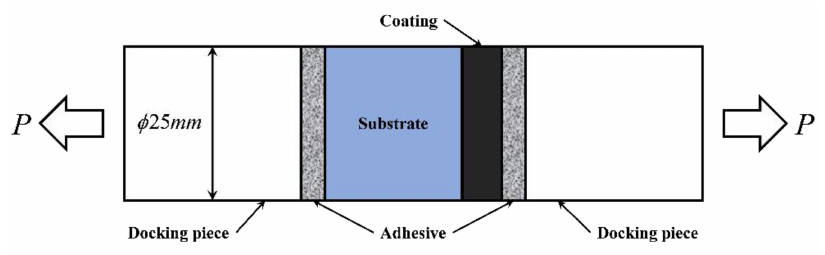
Figure 2. Bonding tensile method to measure the adhesion